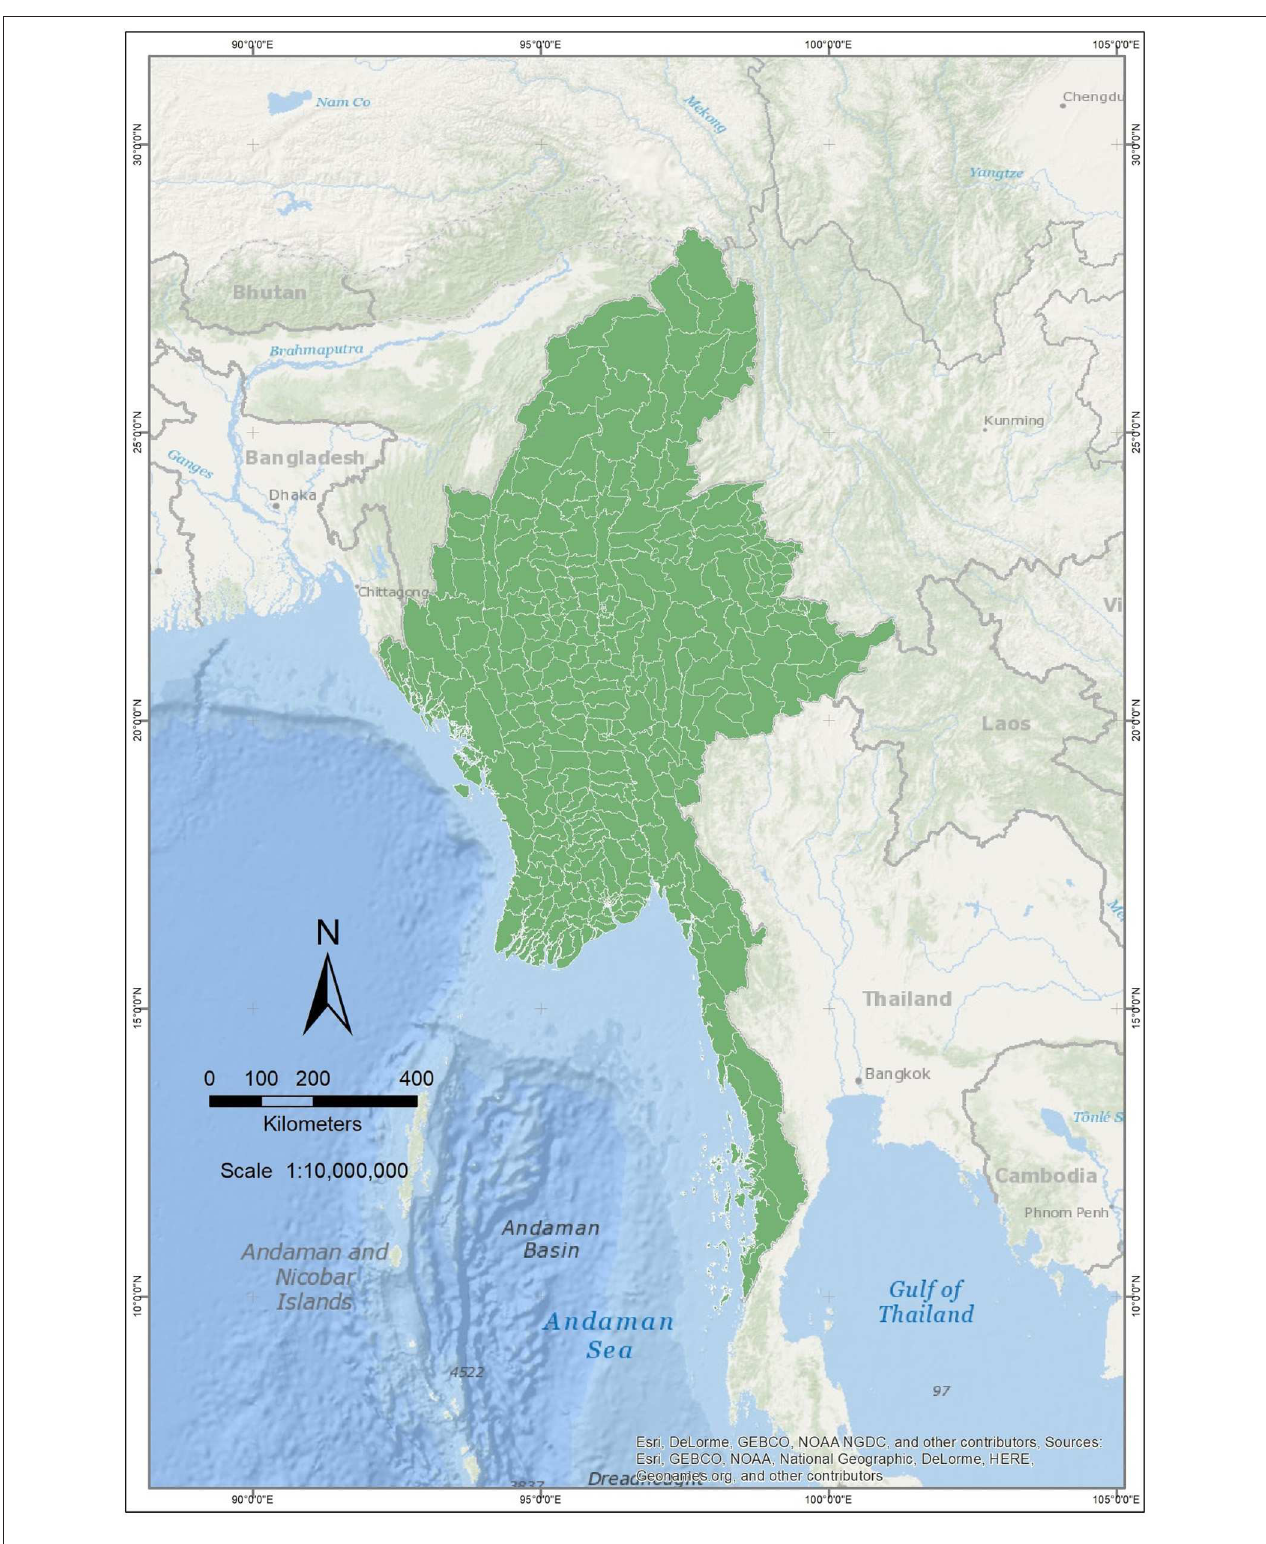
FIGURE 1 | Political map of Myanmar/Southeast